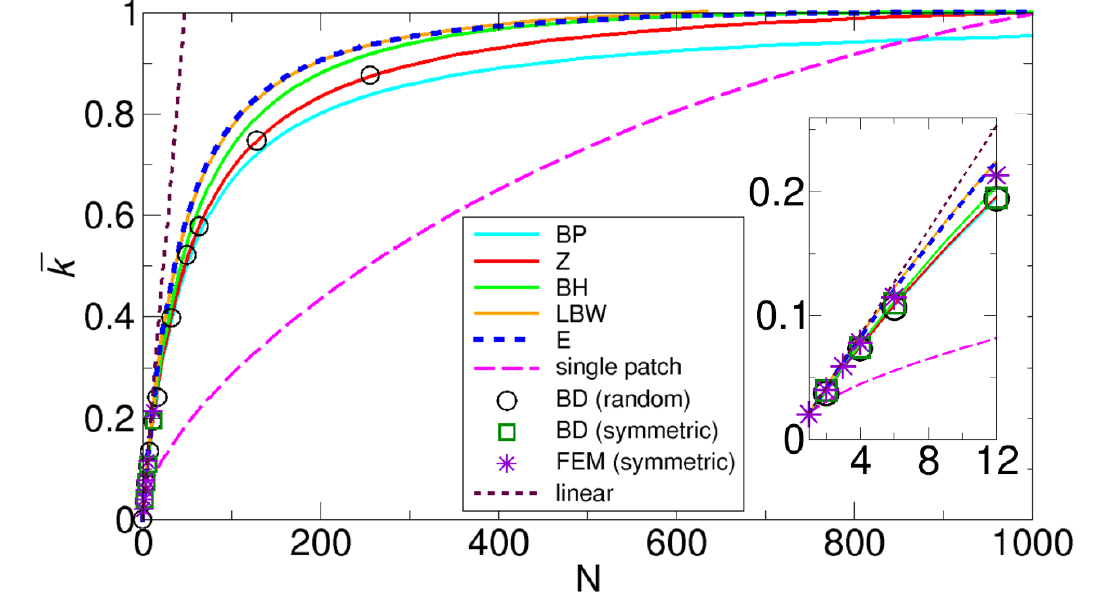
Figure 5. Comparison of the normalized rate constants k as functions of the number of patches N , obtained from various methods for the Northrup system with a patch size of θ = 3.6 ◦ up to N = 1000 ( σ ~1). The normalized constants are calculated from the Berg-Purcell (BP), Zwanzig (Z), boundary homogenization (BH), Lindsay-Berno ff -Ward (LBW), and our (E) theory, whose formulas for k are obtained from Equations (1), (2), (3), (4), and (6), respectively, and the numerical methods from BD simulations, whose results were reported in the Northrup work [26], and the FEM. We also plot the rate constant when all the patches are merged into one larger single patch (single patch) and when there is no competition, so that the overall rate constant is simply linear with the number of patches N (linear). The inset provides a zoomed-in view for a range of N up to 12 for a detailed comparison. Note that, in the inset, the ensemble-averaged rate constants from the BD simulations of random arrangements (black circles) are very close to the rate constants from the BD simulations of symmetric arrangements (green squares). Additionally, note that the lines from the LBW and our theory are very close to each other.